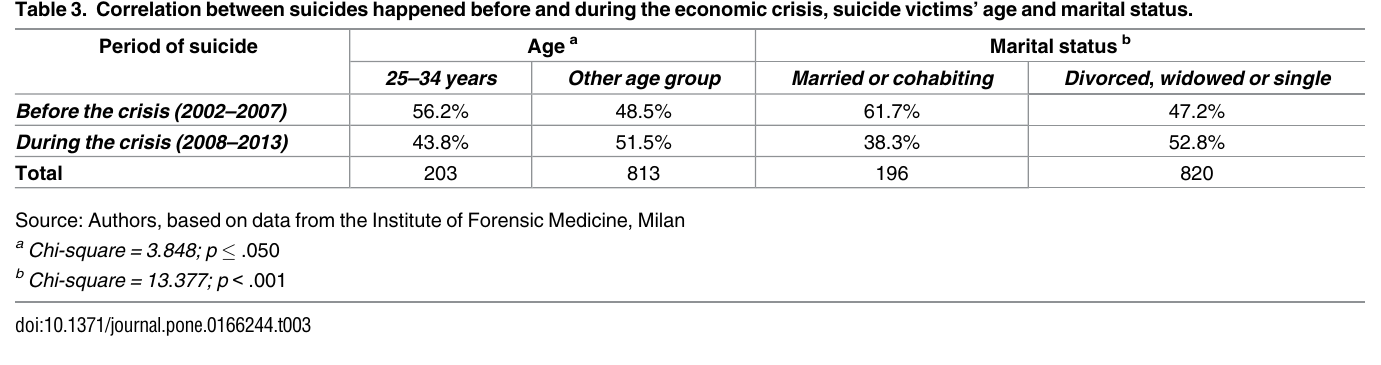
sis than those who were unpartnered. Binary logistic regression was performed to obtain a better understanding of how employ- ment status affected suicide risk in the province of Milan during the economic downturn and to investigate whether the interaction between employment status and health status was an important factor in suicide risk. The binary logistic regression model included the two main independent variables ( employment status and health status ), another independent variable representing the interaction term for these variables ( employment status (cid:3) health status ) and the control variables ( gender , age , marital status and urban context ). The results of the binary logistic regression are summarized in Table 4. The results of the binary logistic regression demonstrate that, among suicide victims in the province of Milan, the likelihood of suicide during the economic crisis is three times higher for persons affected by a severe disease, either physical or psychological, than for people who were not affected. The presence of severe disease was a significant contributor to suicide risk during the economic crisis.